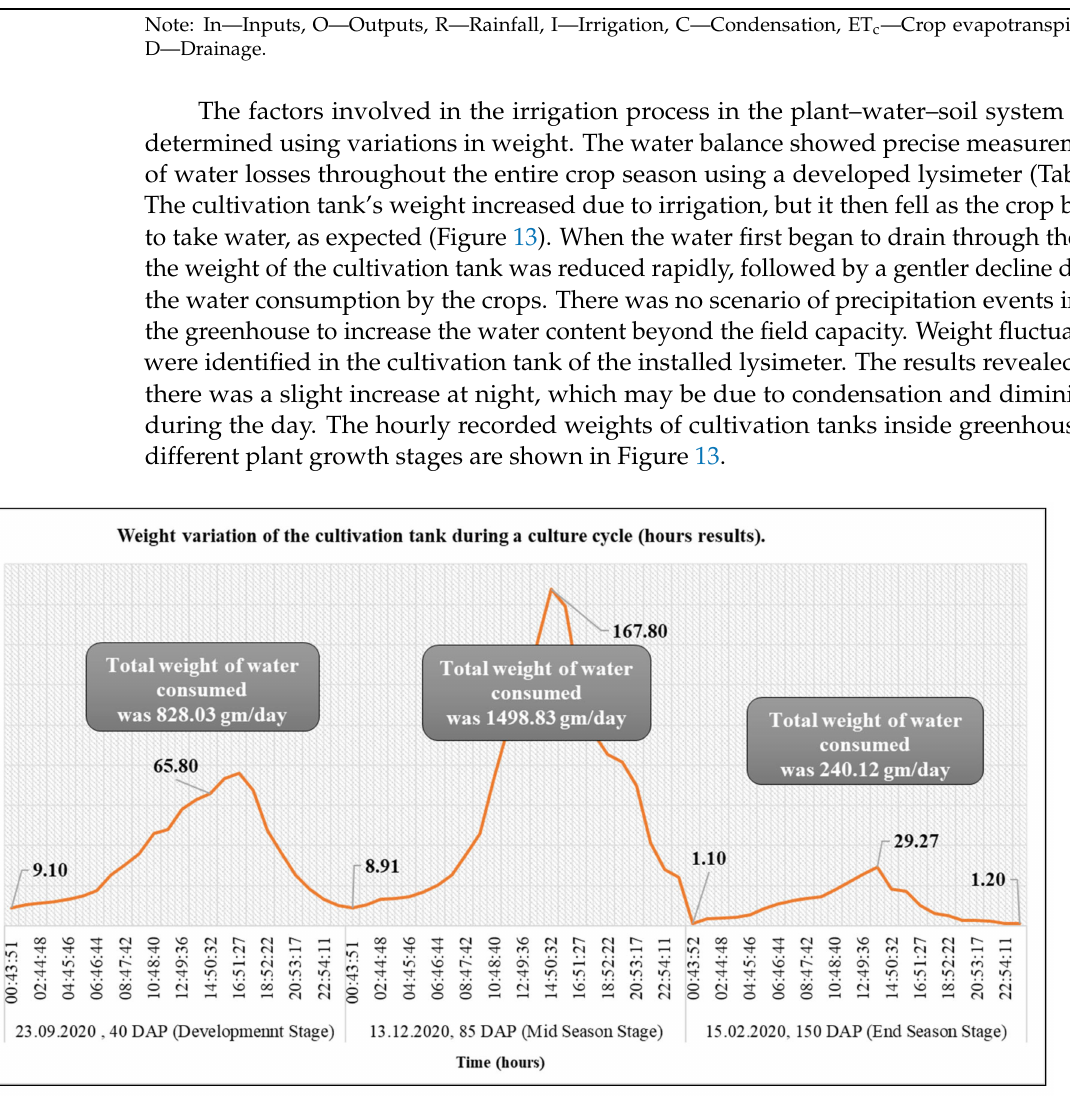
Figure 13. Hourly chrysanthemum lysimeter data showing total weight and cumulative change in water content for a three-day period during different plant growth